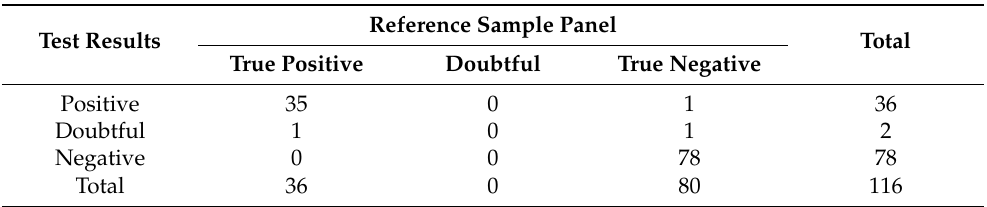
Table 7. Qualitative results of ERADIKIT™ BMSK PLUS obtained using the reference samples panel: cross-tabulation according to the true IBR status of the reference samples.